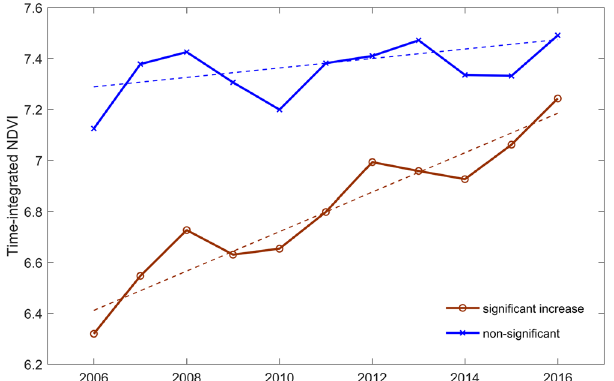
Figure 1. Comparison of time-integrated NDVI for two groups of 2006 land consolidation project: parcels showing significant ( p < 0.05) upward trends as one group and all the remaining parcels as the other group. Sen’s slopes (dash lines) were estimated for two groups.